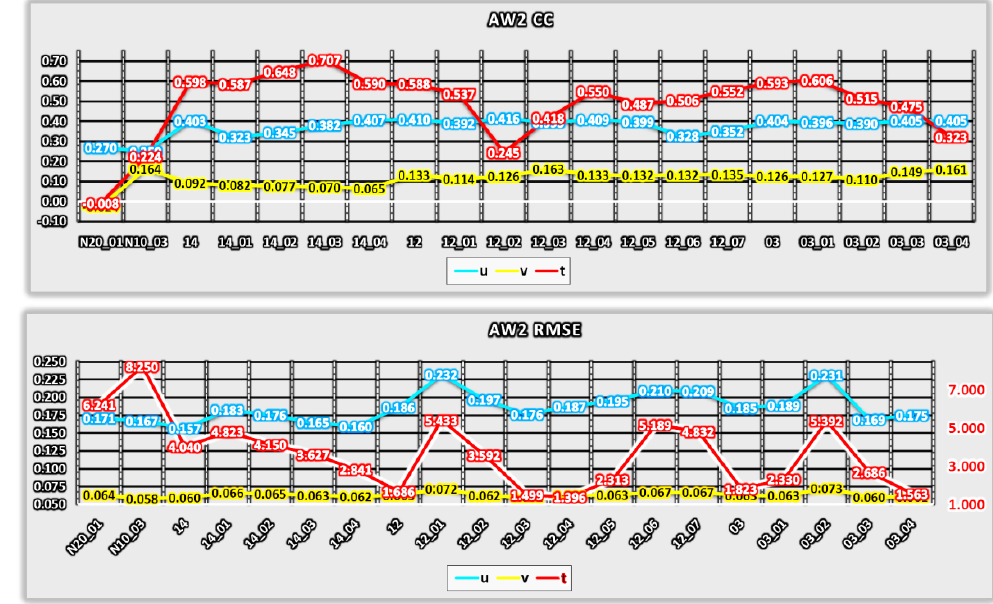
Figure 10. Correlation coefficient and RMSE of surface temperature for model results and HYCOM data